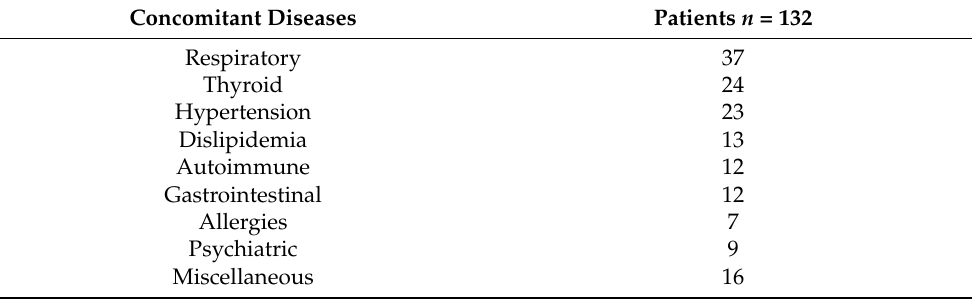
Table 2. Concomitant diseases in South Italian CSU patients.